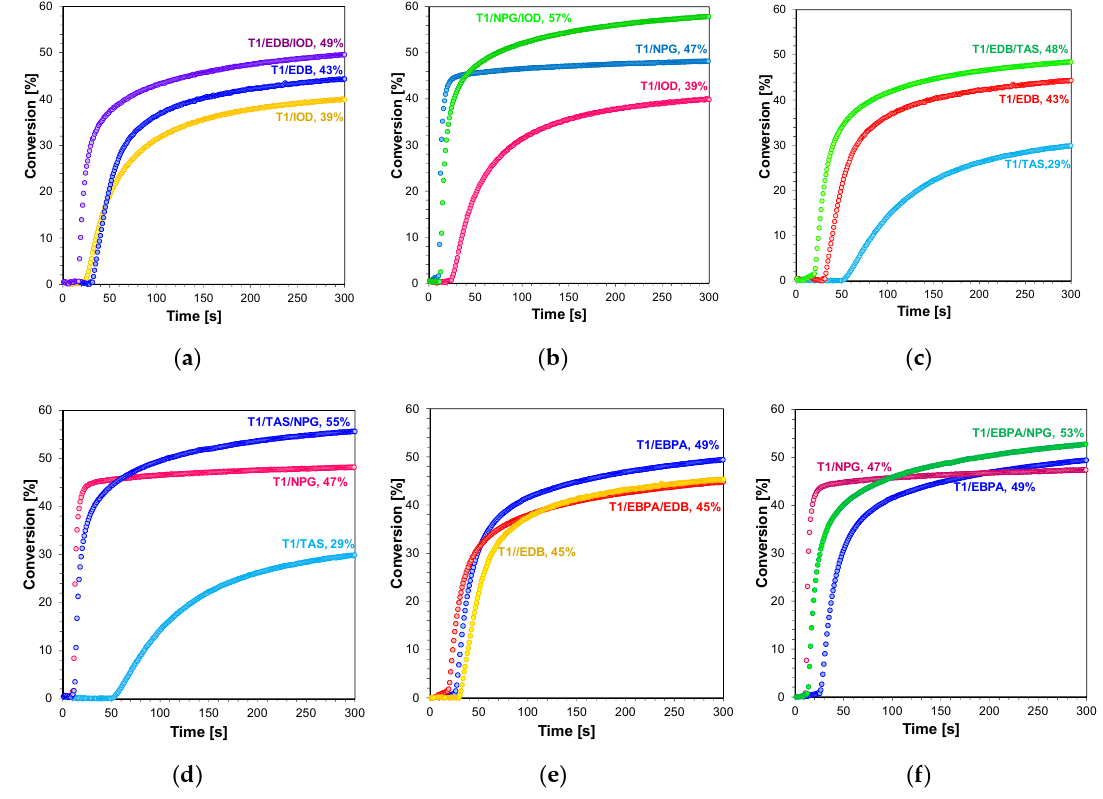
Figure 9. Polymerisation profiles of TMPTA (acrylate function conversion vs. irradiation time) upon exposure to the visible LED@420 nm (0.60 mW·cm − 2 ) in laminate in the presence of different photoinitiating systems ( a ) T1/EDB/IOD, T1/EDB, T1/IOD, ( b ) T1/NPG/IOD, T1/NPG, T1/IOD, ( c )